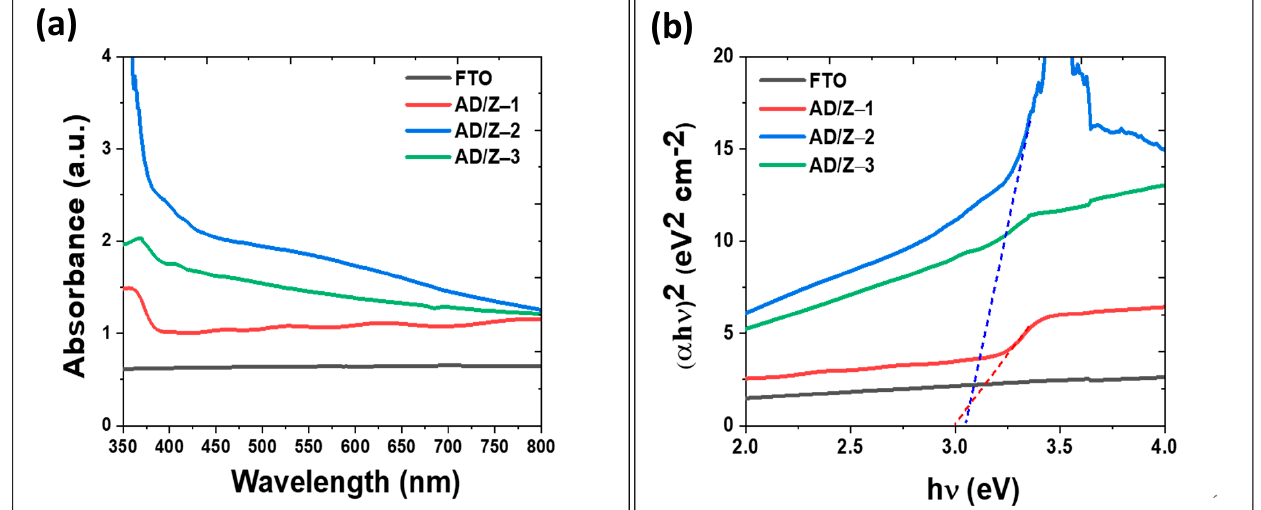
Figure 5. ( a ) UV–visible absorption spectra, and ( b ) Tauc plot of the ZnO films deposited using different AD flow rates.